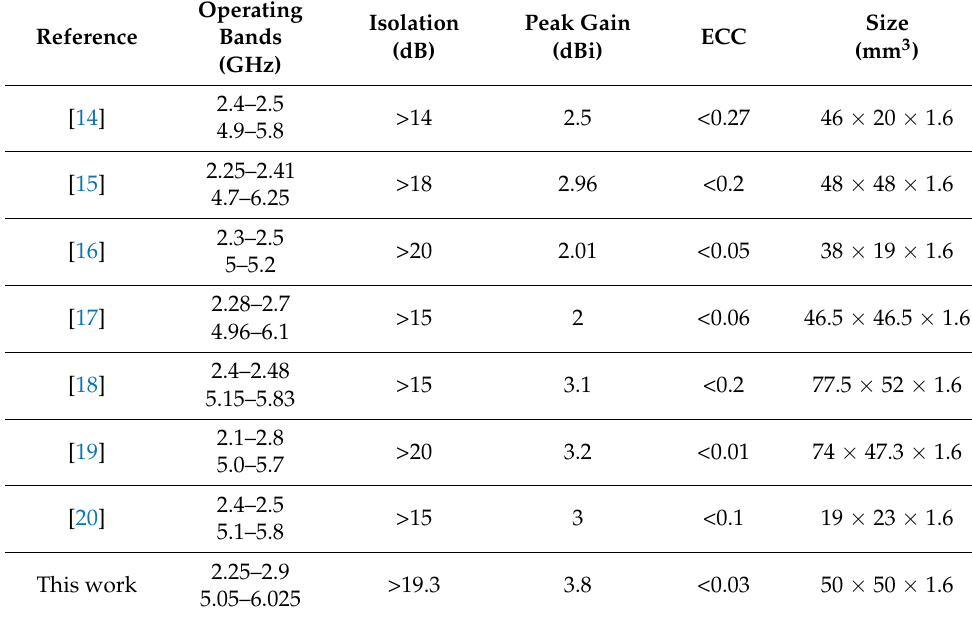
Table 2. Comparison with recently published